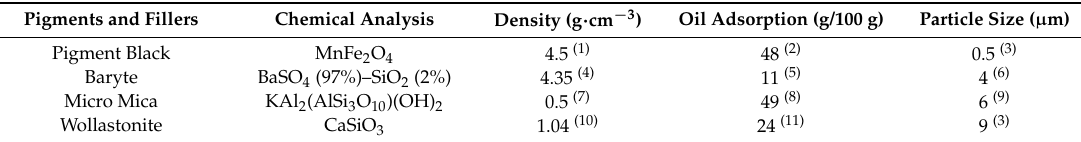
Table 2. Pigment and